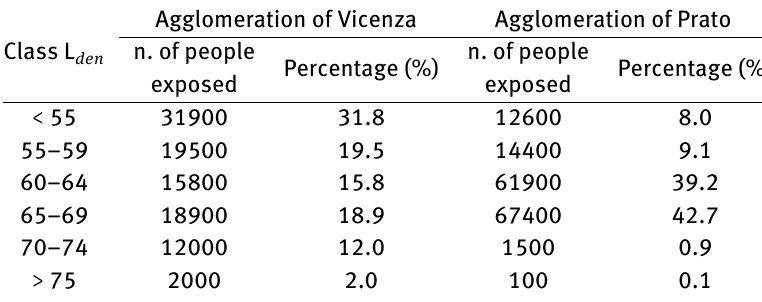
Table 3: Values of population exposed to noise (L den ) for the agglomerations of Vicenza and